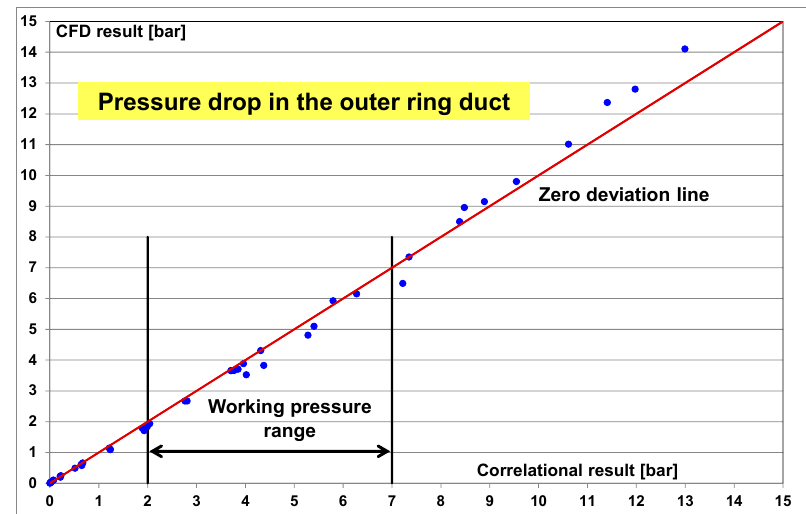
Figure 18. Comparison between numerical and analytical pressure drop results for outer ring cooling flows ranging between 3 and 415 L/h.